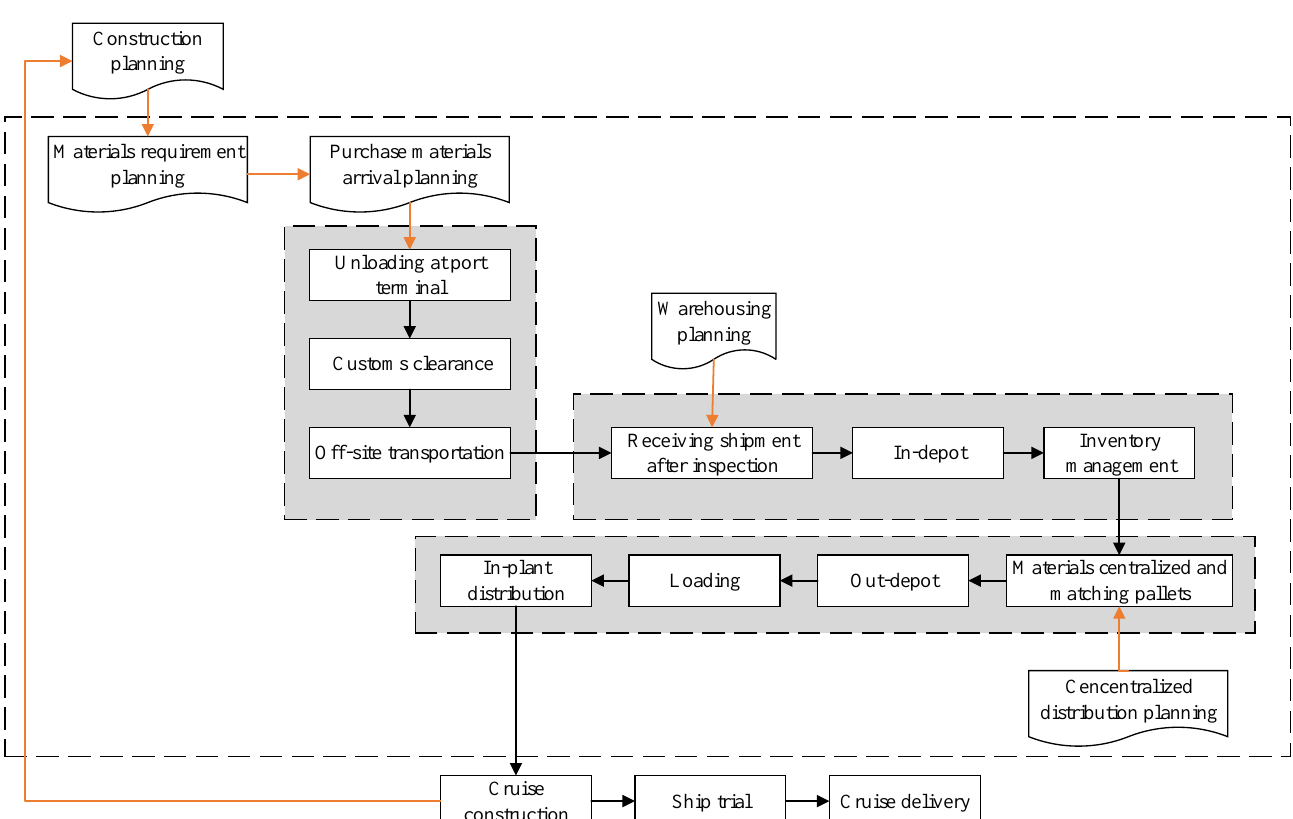
Figure 3. Concentralized distribution logistics process in cruise-building imported